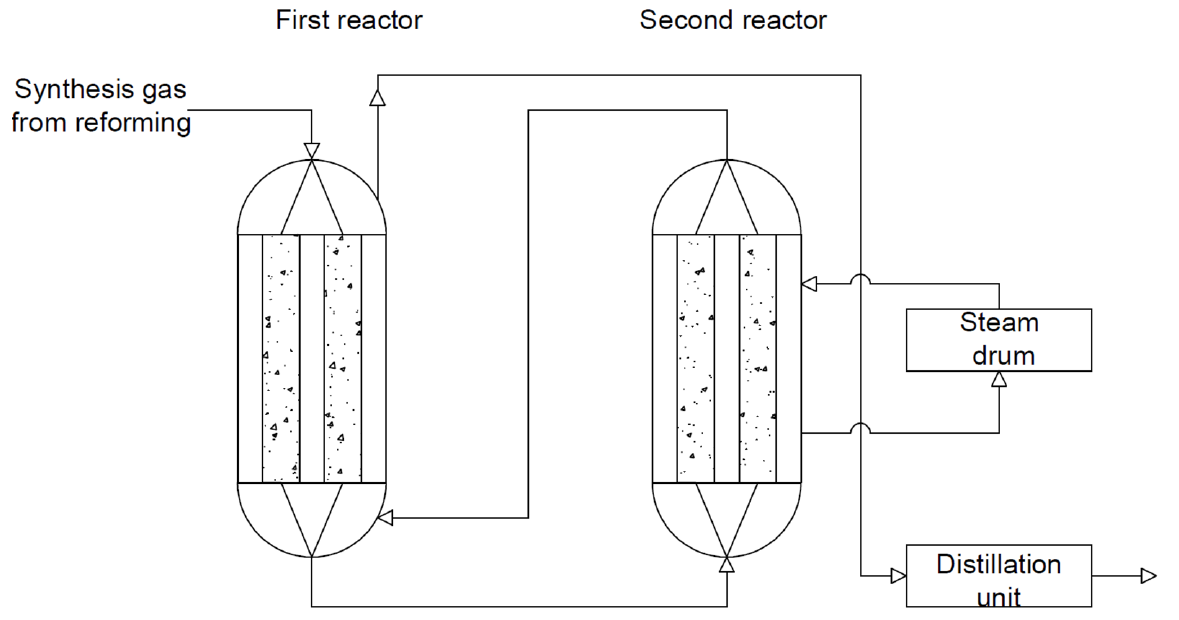
Figure 13. Coupled reactors in a double-reactor system. Developed based on [1]. (b) Tubular membrane reactors